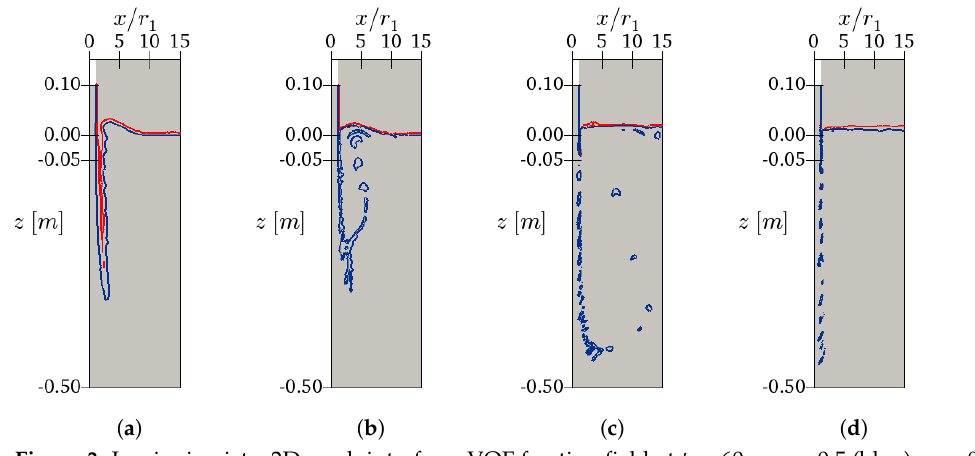
Figure 3. Impinging jet—2D mesh interface. VOF fraction field at t = 60 s. α = 0.5 (blue), α = 0.1 (red). Mesh: ( a ) W8. ( b ) W16. ( c ) W32. ( d ) W64.